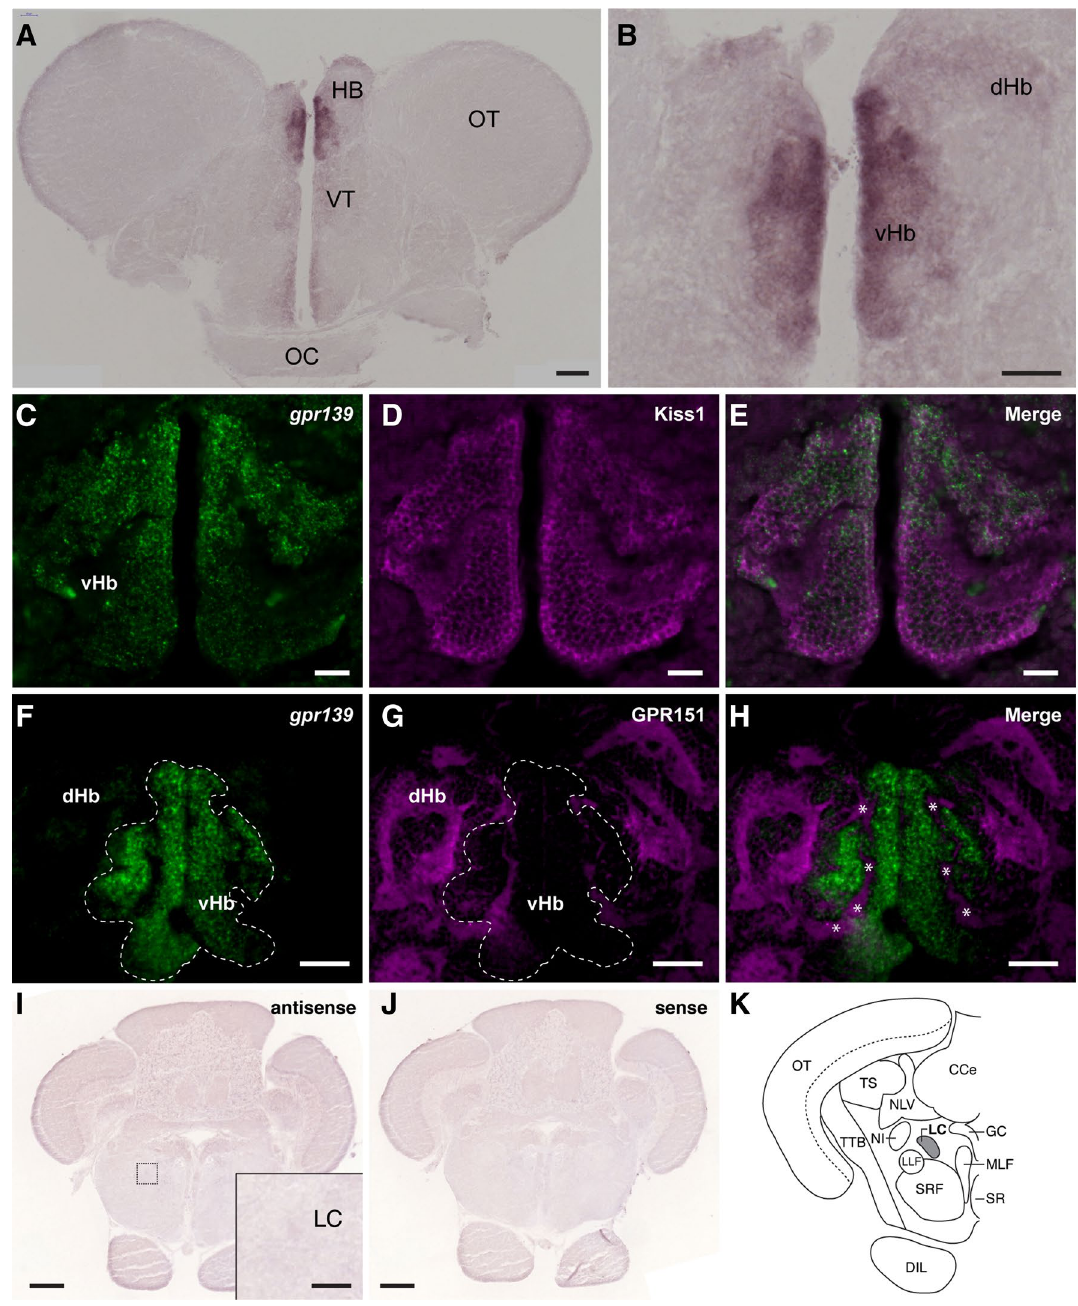
Figure 1. Localisation of gpr139 mRNA expression in the brain of zebrafish. In situ hybridisation shows expression of gpr139 mRNA in the ventral habenula (vHb) ( A , B ). Double labelling of gpr139 mRNA ( C , F ) with Kiss1 ( D ) or GPR151( G ) immunofluorescence further confirmed specific expression of gpr139 mRNA in the vHb ( E ) but not in the dorsal habenula (dHb) ( H ). In the vHb, GPR151-immunoreactive neuropil structure is also seen, which are derived from the dHb ( H , asterisks ). In the hindbrain region, no expression of gpr139 mRNA was detected in the locus coeruleus ( I – K ). The dotted box indicates the location for the inset in the panel I. HB habenula; VT ventral thalamus; OT optic tectum; OC optic chiasma; dHb dorsal habenula; vHb ventral habenula; LC locus coeruleus; TS torus semicircularis; CCe cerebellar corpus; NLV nucleus lateralis valvulae; GC central gray; MLF nucleus of the medial longitudinal fascicle; NI nucleus isthmi; LLF lateral longitudinal fascicle; SRF superior reticular formation; SR superior raphe nucleus; TTB tecto-bulbar tract; DIL , diffuse nucleus of inferior lobe. Scale bars: ( A , F – H ), 100 µm; ( B ) inset of ( I ), 50 µm; ( C – E ), 20 µm; ( I , J ), 200